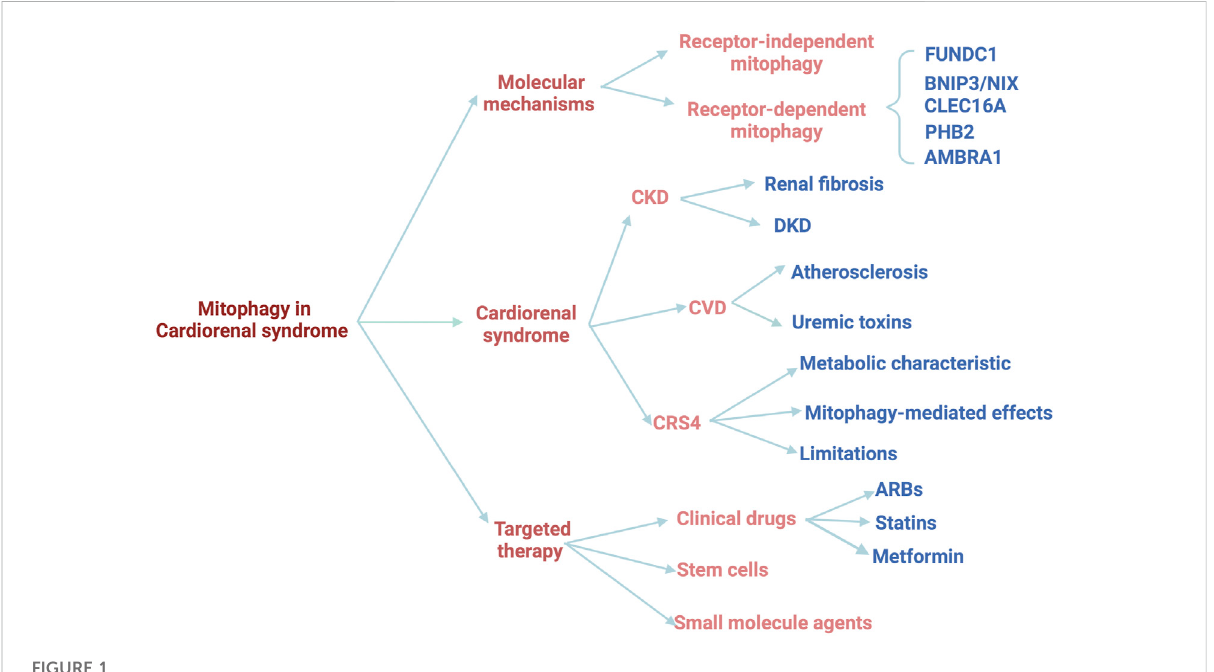
FIGURE 1 The schematic diagram of the review.